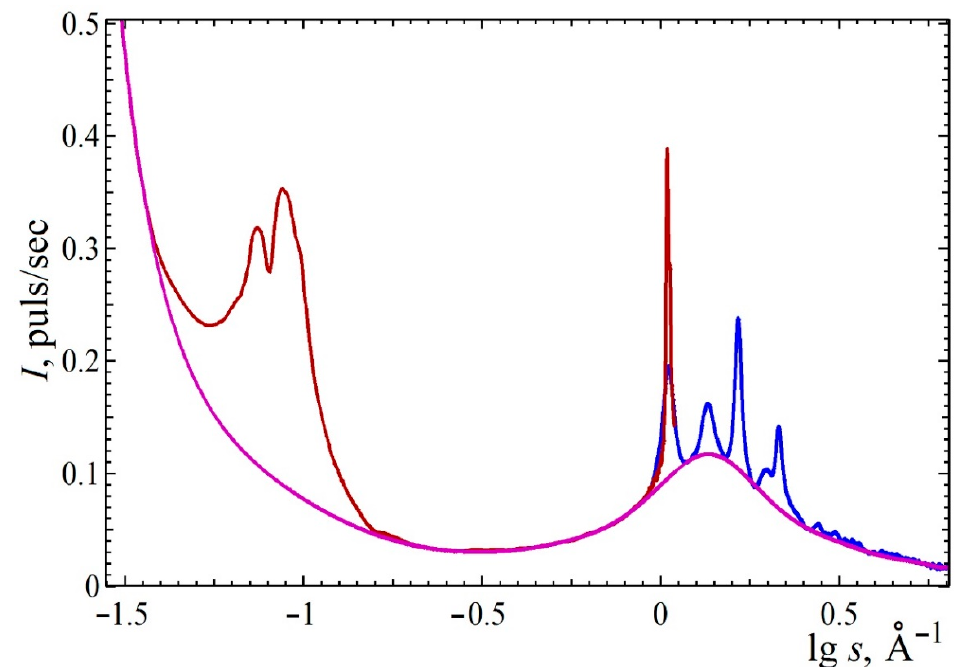
Figure 3. Experimental scattering intensity from poly(2-methyl-2-oxazoline). Red line: small-angle scattering part; blue: wide-angle diffraction pattern; magenta: baseline corresponding to the scattering from the disordered phase.